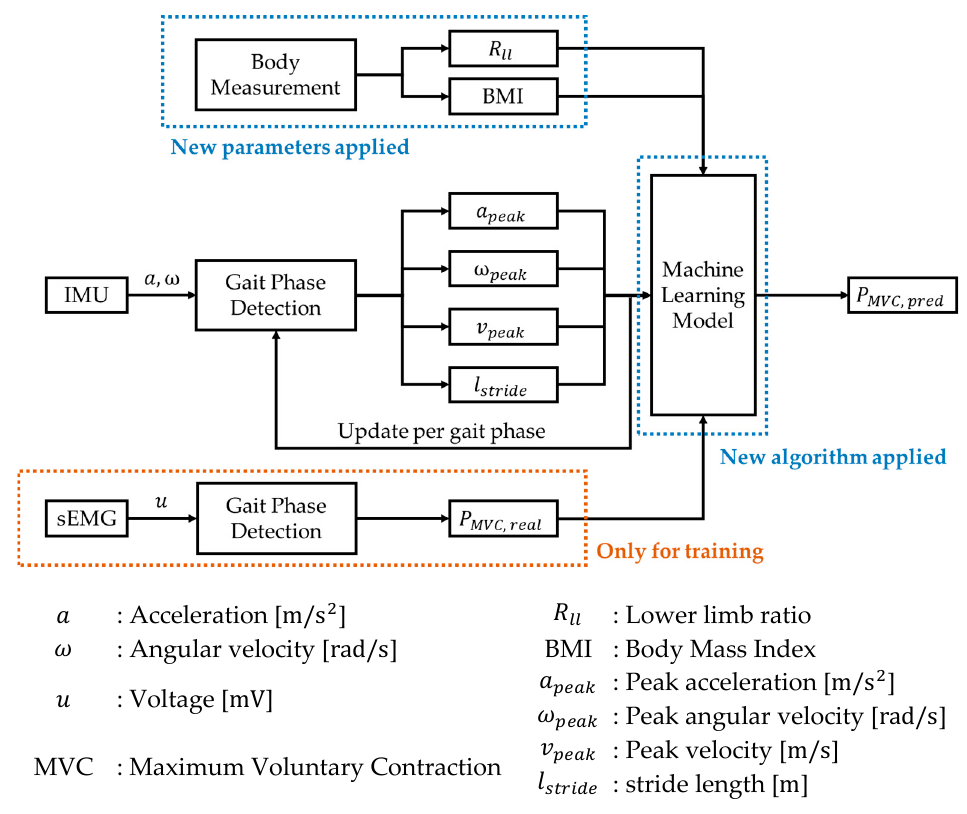
Figure 7. Overview of muscle activity estimation system.